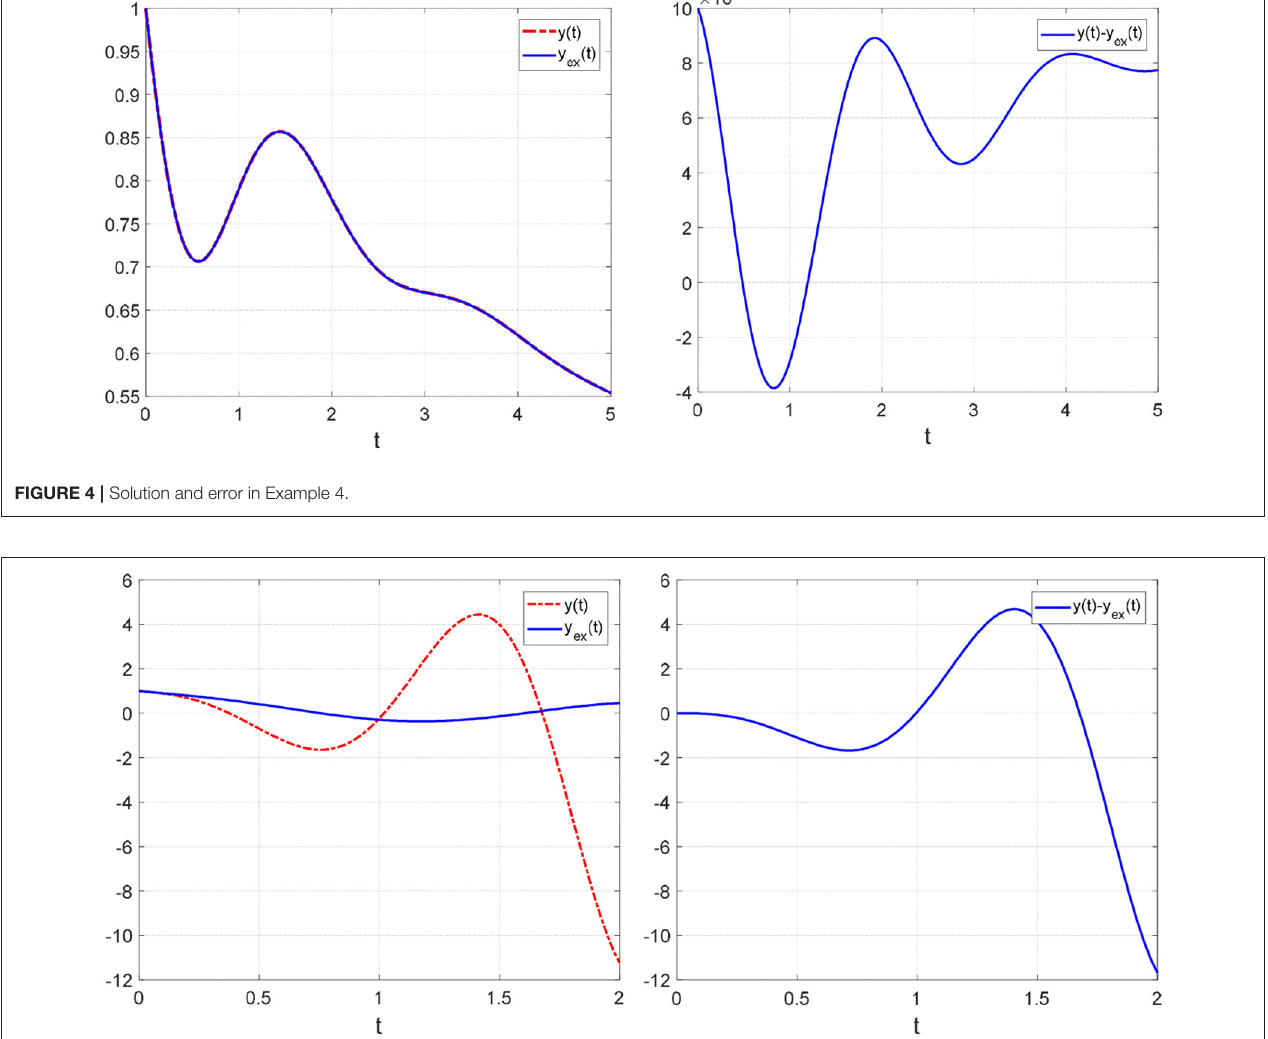
FIGURE 5 | Solution and error in Example